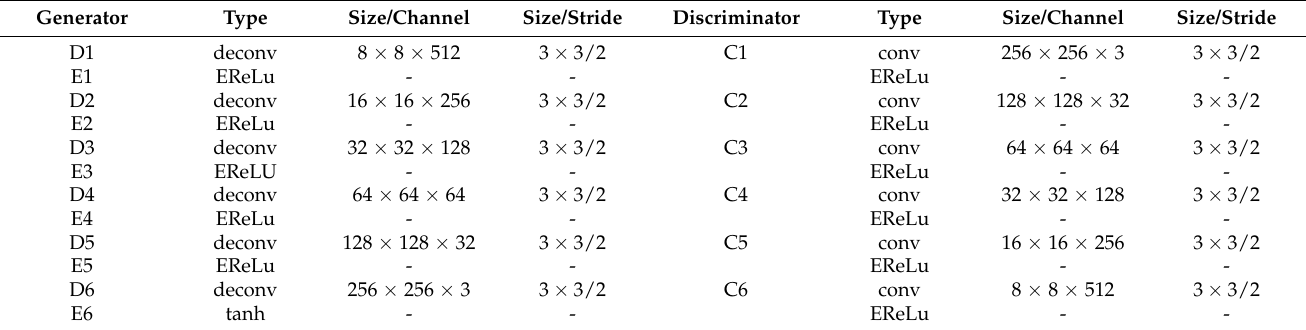
Table 1. The network framework of the